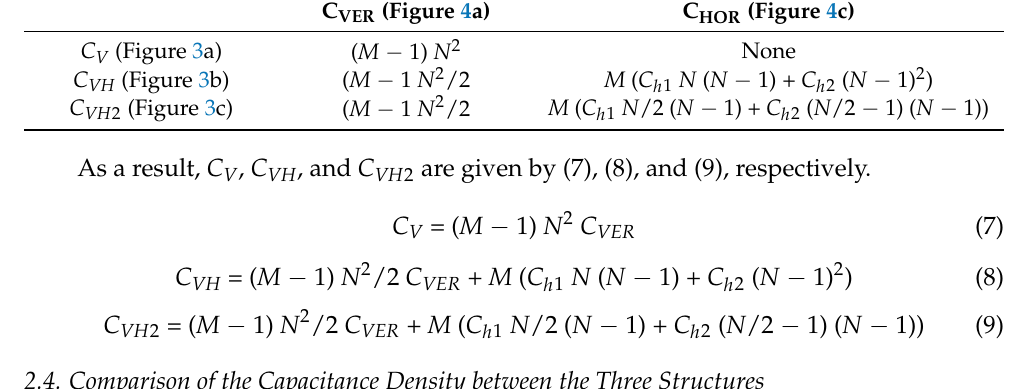
Table 1. Number of capacitance components for the three capacitor structures. C VER (Figure